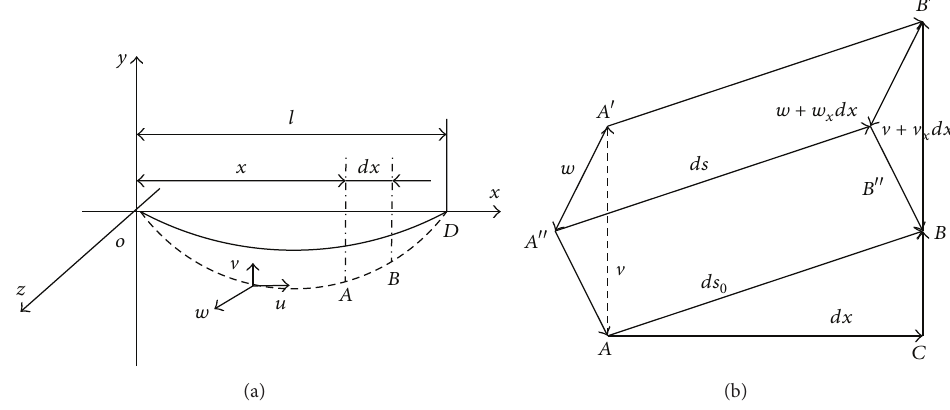
Figure 1: Model of the transmission line: (a) cable model and (b) infinitesimal